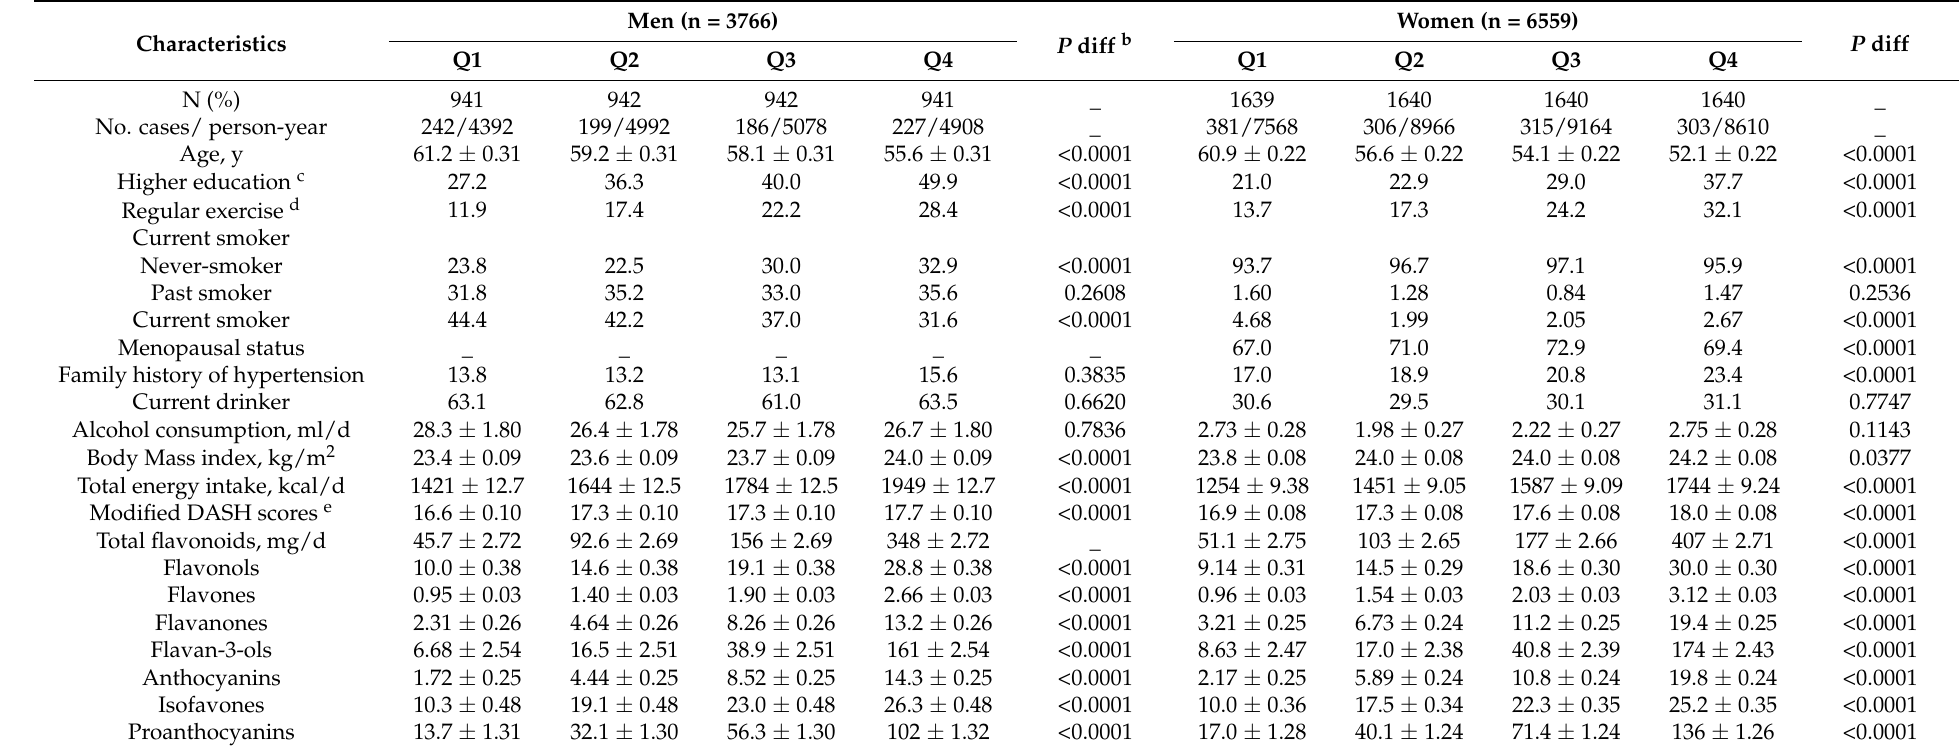
Table 1. Age-adjusted characteristics of the study participants by dietary intake of total flavonoids (n = 10,325) a